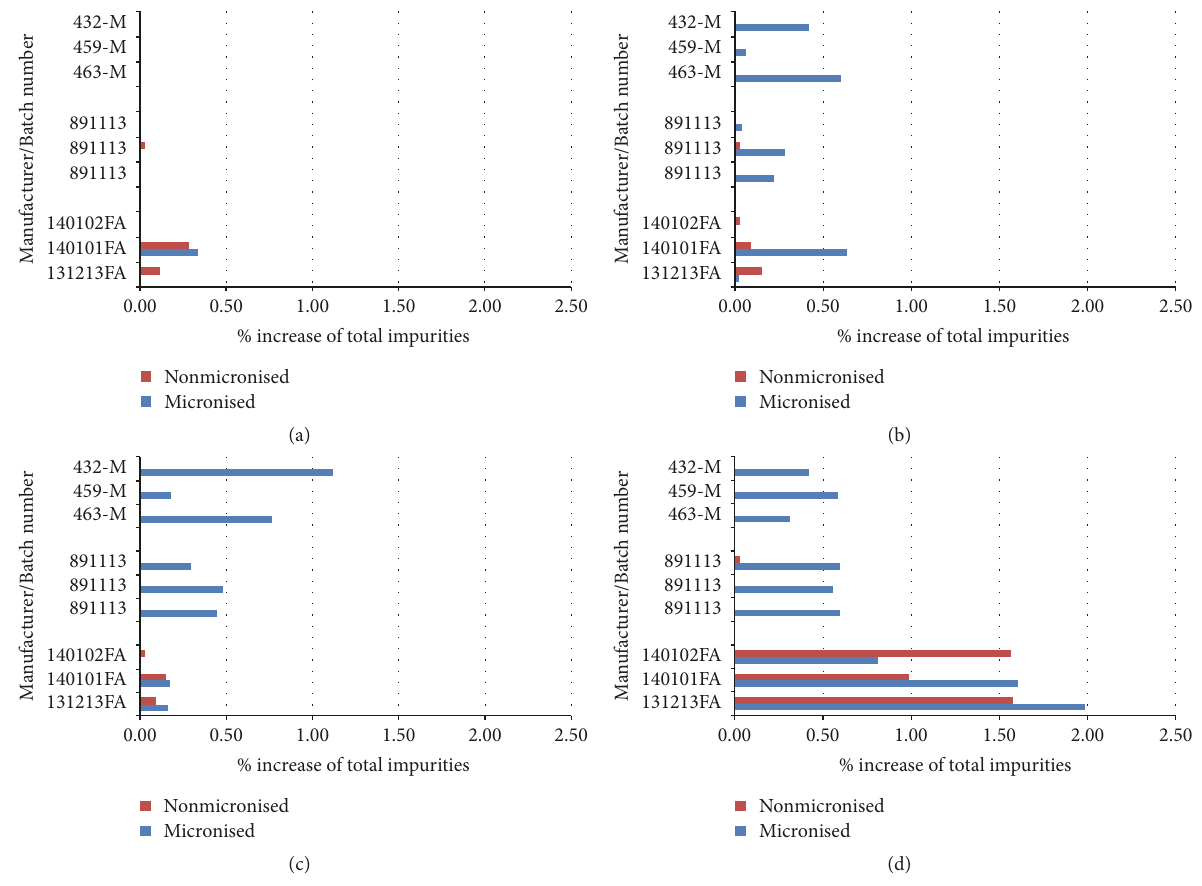
Figure 4: Results of stability studies of FA performed at 5 ∘ C ± 3 ∘ C (a), 25 ∘ C/60% RH (b), and 40 ∘ C/75% RH (c) as well as under photolytic stress conditions as described in ICH Q1B (d).